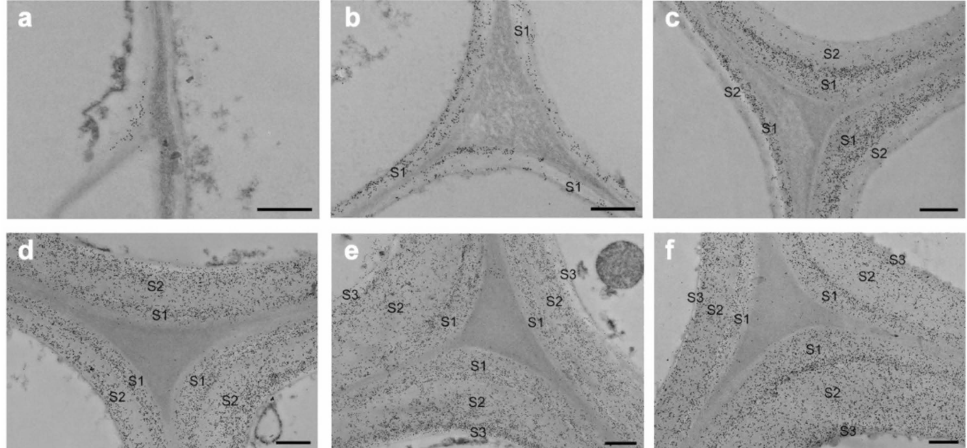
Figure 5. Immunogold localization of glucomannans in Cryptomeria japonica tracheids that are differentiating and differentiated: ( a ) tracheids in the early stages of S1 development; ( b ) tracheids in the formation stage of S1 layer; ( c ) tracheids in the early stages of S2 development; ( d ) tracheids in the formation stage of S2layer; ( e ) tracheids in the early stages of S3 development; ( f ) mature tracheids. Bar = 500 nm